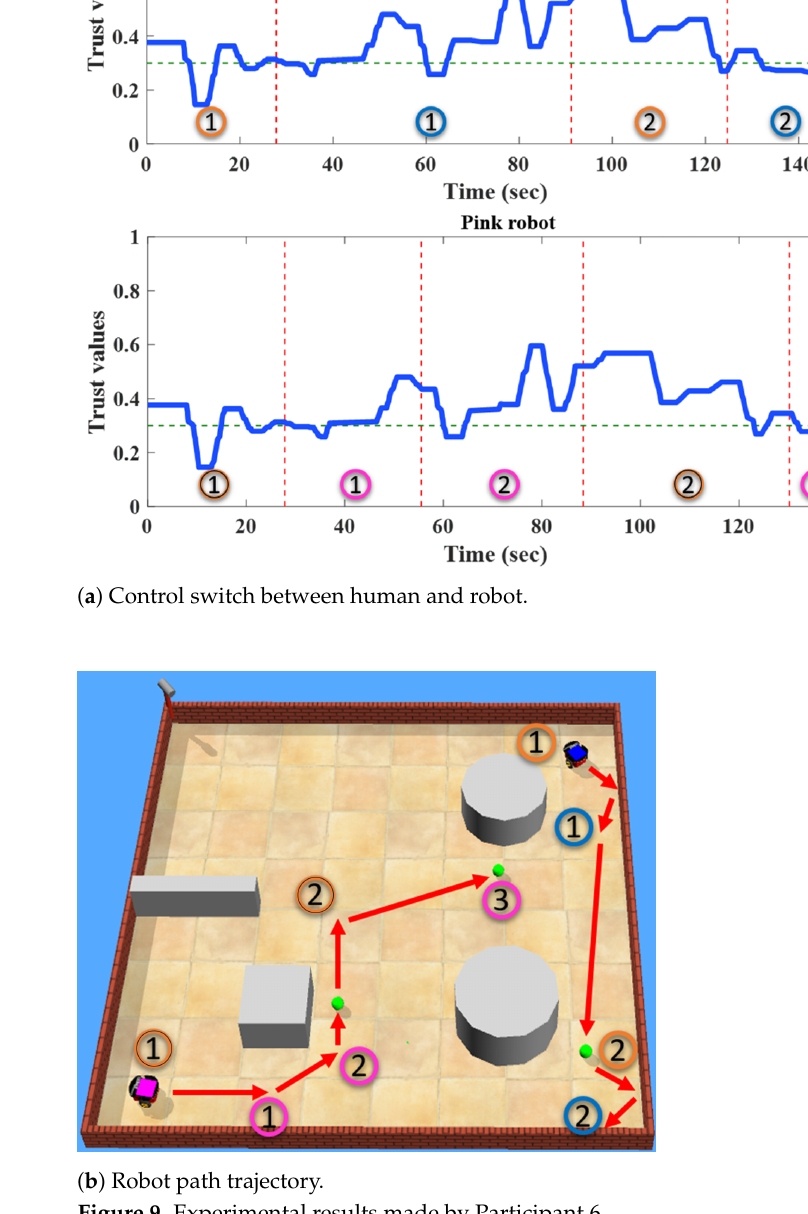
Figure 9. Experimental results made by Participant